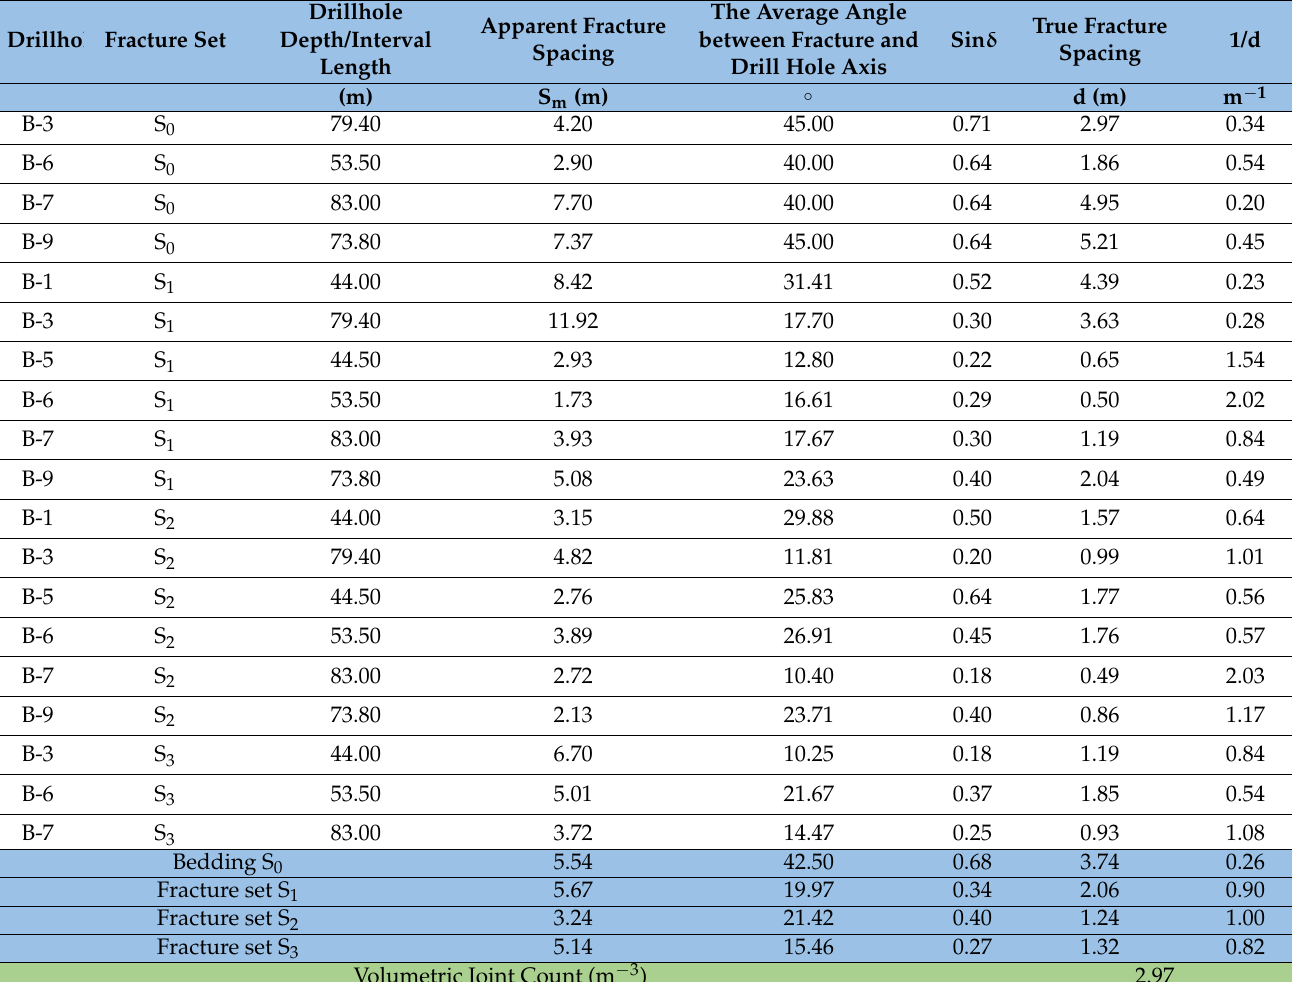
Table 3. Spatial distribution properties: apparent fracture spacing (S m ), average angle between fracture and drill hole axis and true fracture spacing (d) for each interpreted discontinuity set, and Volumetric Joint Count (J v ) for the discontinuity pattern system.